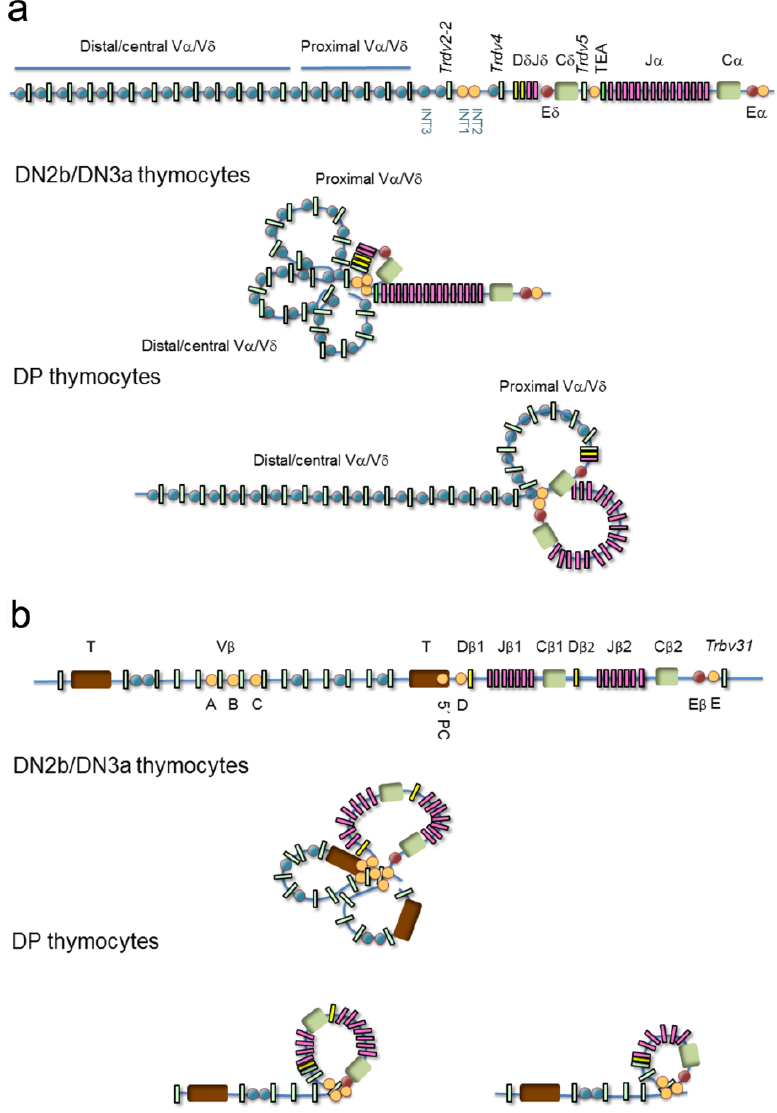
Figure 6. Models of chromatin loop configuration at the T-cell receptor (TCR) loci: TCR α / TCR δ and TCR β . Variable (V), diversity (D), and joining (J) gene segments are represented by green, yellow and pink rectangles, respectively. The T early α exon (TEA) is represented as an orange rectangle. Trypsinogen genes (T) are represented by brown rectangles. Enhancers are represented by red circles. CTCF binding sites (CBSs) are represented by blue or orange circles (the orange circles indicate the most relevant CBSs involved in three-dimensional gene structure). ( a ) The TCR δ recombination center (RC) is established by a chromatin loop between INT1 / 2 and TEA promoter (TEAp) CBSs in double-negative 2b (DN2b) / double-negative 3a (DN3a) thymocytes, whereas the 5 (cid:48) V α / δ and V δ gene segment region forms additional loops that result in locus contraction. In double-positive (DP) thymocytes, the TCR α RC is established by a chromatin loop between TEAp and TCR α enhancer (E α )-adjacent CBSs, whereas additional loops are formed between the RC CBSs and CBSs associated with proximal V α gene segments to facilitate processive V α J α rearrangements. ( b ) In DN3a thymocytes, the TCR β RC is established by a loop between CBSs present upstream of the D β 1 promoter and downstream of the TCR β enhancer (E β ), whereas additional loops are formed among the V β associated CBSs resulting in locus contraction, thereby facilitating the usage of distal V β gene segments. In DP thymocytes, the V β region presents an extended configuration that is involved in maintaining allelic exclusion.